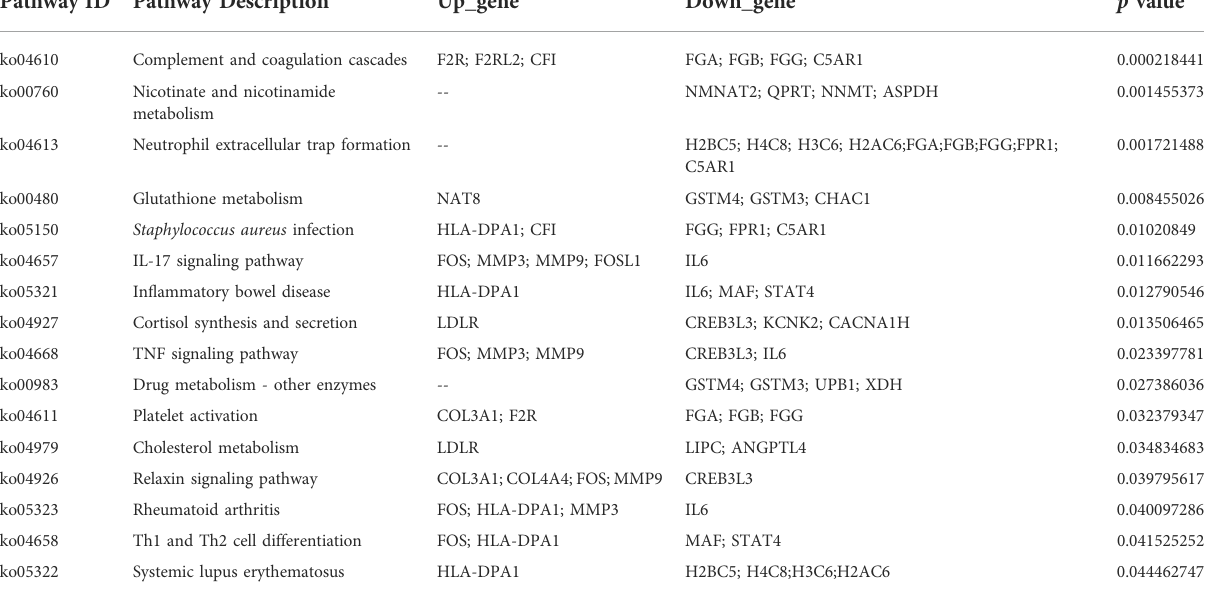
TABLE 1 Signi fi cantly enriched pathways based on KEGG pathway analysis. Pathway ID Pathway